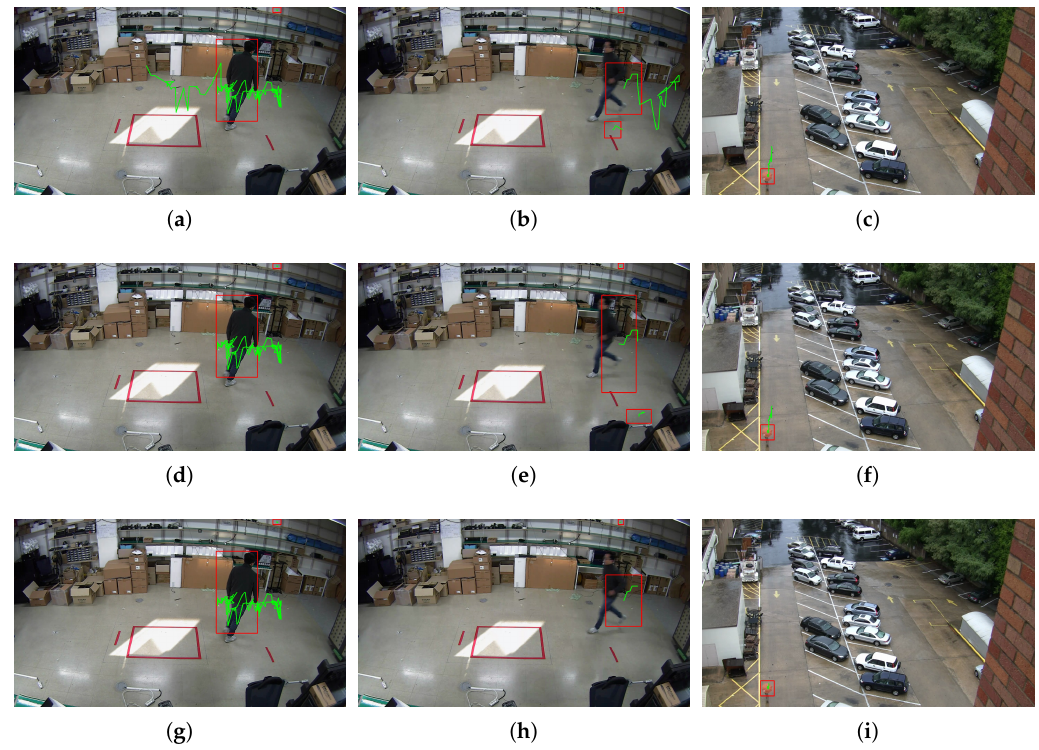
Figure 14. Moving object tracking by the proposed method with different α thresholds: α = 0.25 in ( a – c ), α = 0.4 in ( d – f ), and α = 0.5 in ( g – i ).